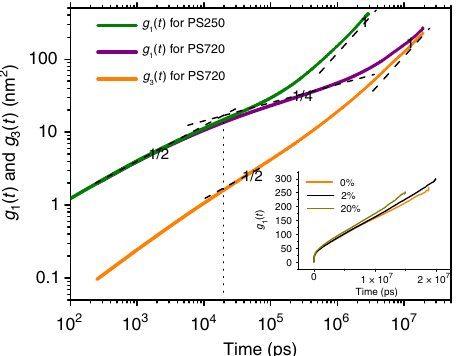
Fig. 1 The MSD of the two inner-most monomers g 1 ð t Þ on chain backbone for both PS250 and PS720 chains, and that of the center of mass (CM) g 3 ð t Þ for PS720 chains. The dash lines with scaling factors (1/4, 1/2, and 1) are plotted as references. The vertical dotted line indicates an intersection at τ (cid:4) (cid:5) 20 ns in g 1 ð t Þ . The inset shows the comparison of g 1 ð t Þ for pure PS720 melt and two composite systems with NP loading of 2% and 20%.